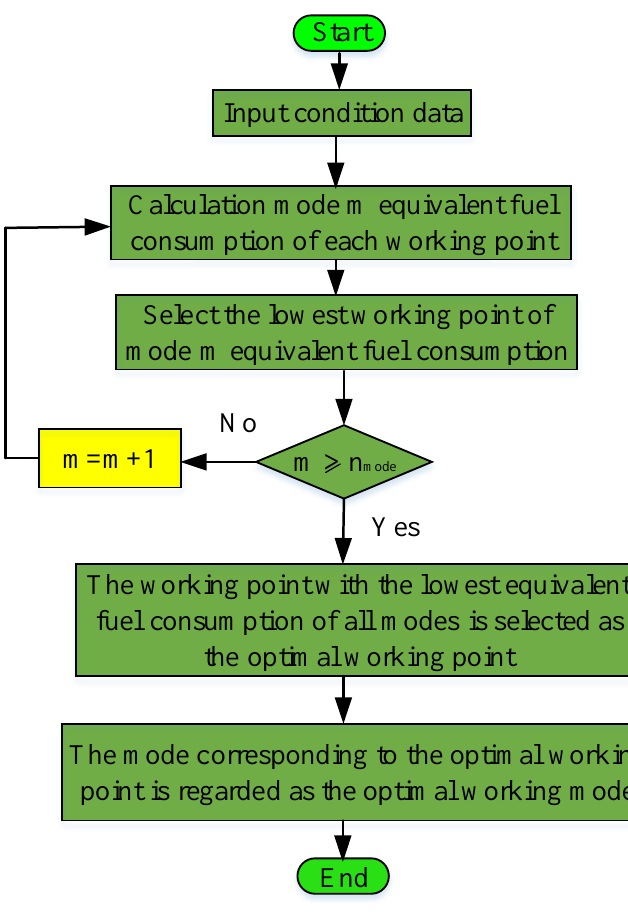
Figure 4. The equivalent fuel consumption minimization strategy (ECMS) flow chart considering mode switching.